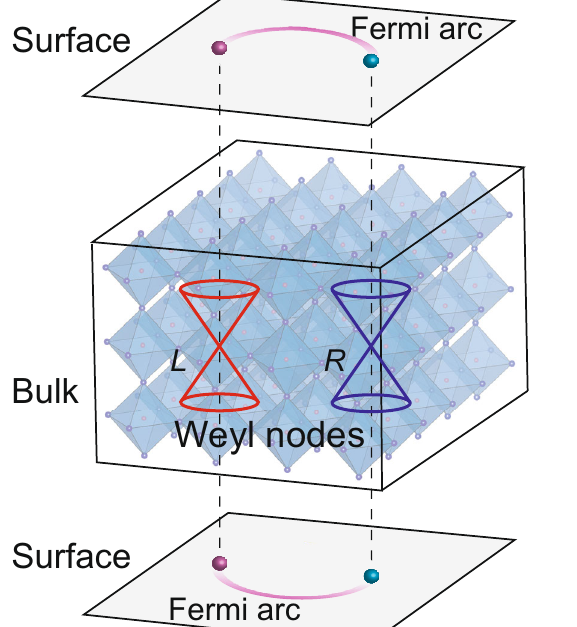
Fig. 7 Schematic diagram of a pair of Weyl nodes with opposite chiralities ( L and R ) and surface Fermi arcs in SrRuO 3 . The pink curves represent surface Fermi arcs connecting the projections of the bulk Weyl